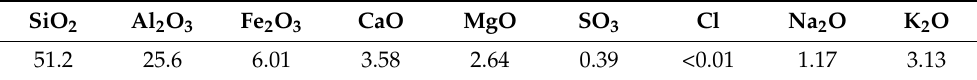
Table 4. Chemical composition of the granulated ground blast furnace slag used in the study [% by